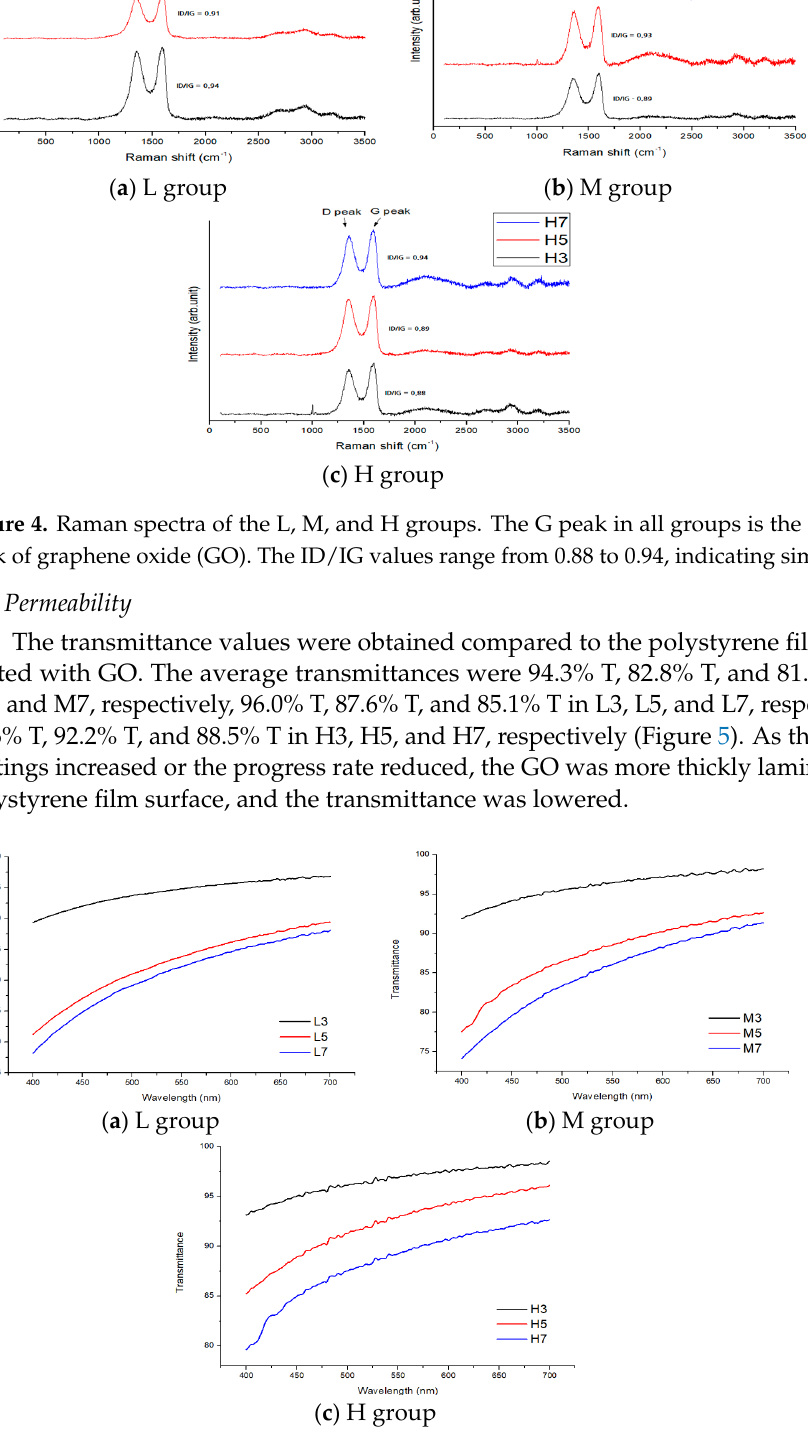
Figure 5. Transmittance spectra of the L, M, and H groups. The transmittance is highest in the H group and in the films with three coatings in any group.